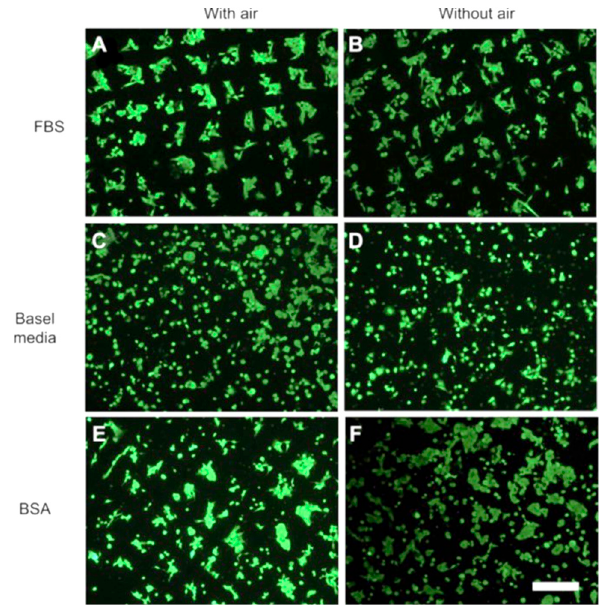
Figure 6. Scanning electron microscopy images of HeLa cells attached to superhydrophobic/superhydrophilic microtemplates under different experimental conditions: cells cultured for one, two, and four days with ( A , C , E ) and without trapped air ( B , D , F ), respectively. Scale bar ¼ 200 mm. Reprinted from reference [97] with permission from Elsevier.